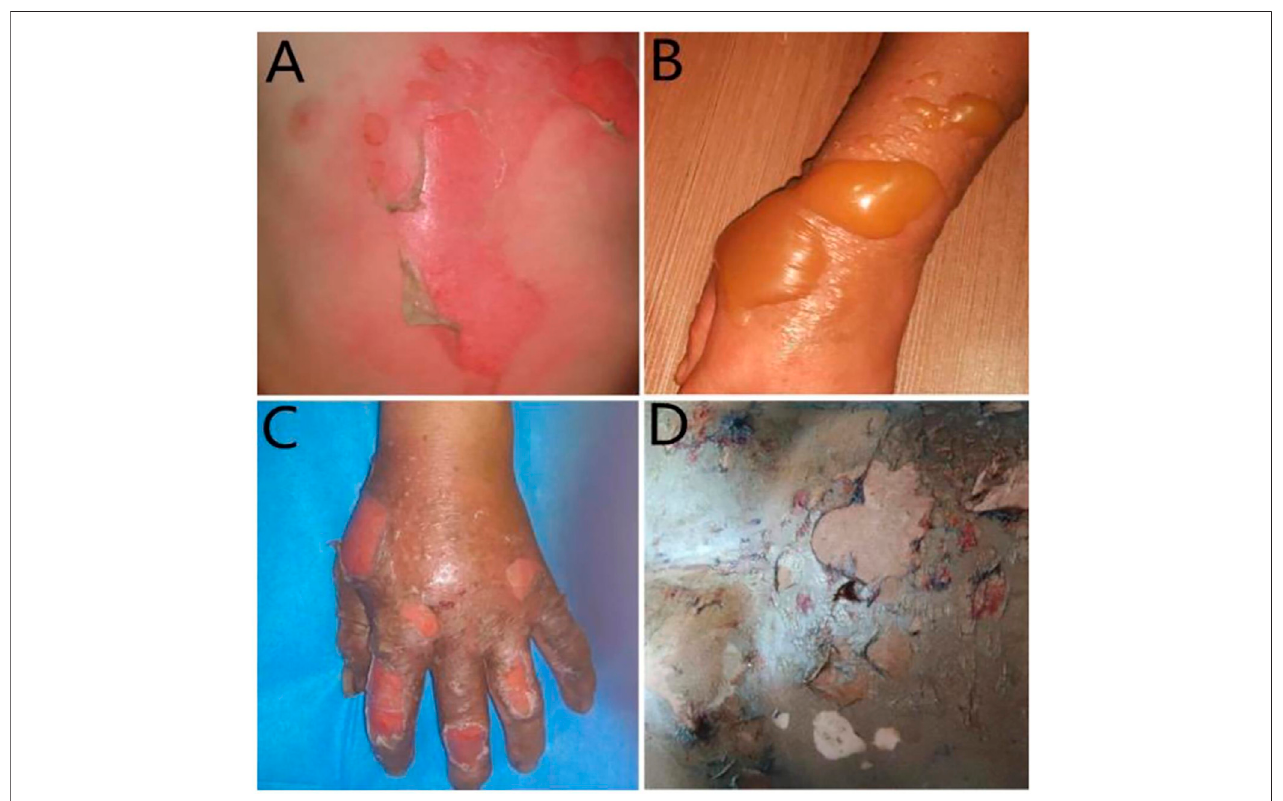
FIGURE 1 | Burn wounds. (A) First degree. (B) Super fi cial second degree. (C) Deep second degree. (D) Third degree.